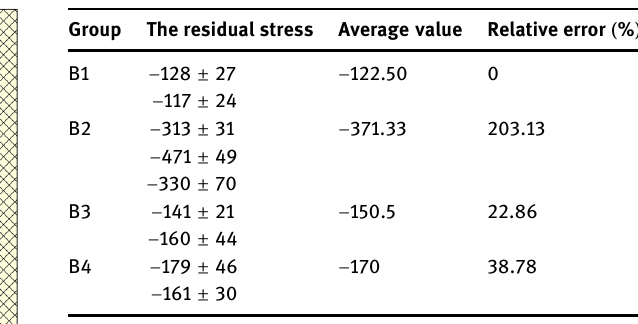
Table 8: The residual stress data of friction disc ( unit: MPa )